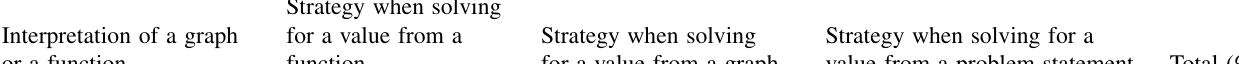
TABLE VI. Profiles for problem solving strategies with different representational task formats in the context of work. Interpretation of a graph or a